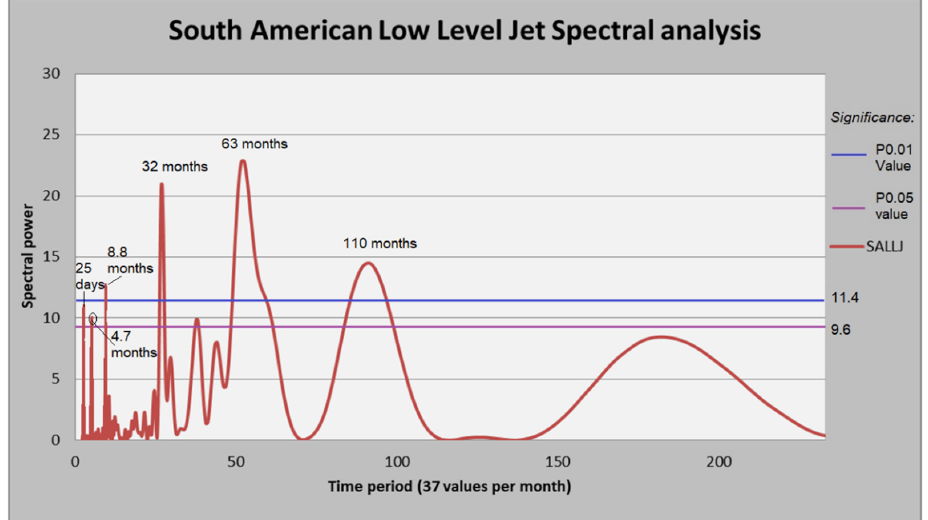
Figure 7. Spectral analysis of the SALLJ intensity for the period 1979–2018 at its own scale in which 37 values correspond to one month. The red line represents the variability of the spectral power, while the blue line represents the minimum value of significance P0.01 (11.4), and the purple line represents the minimum value of P0.05 (9.6).